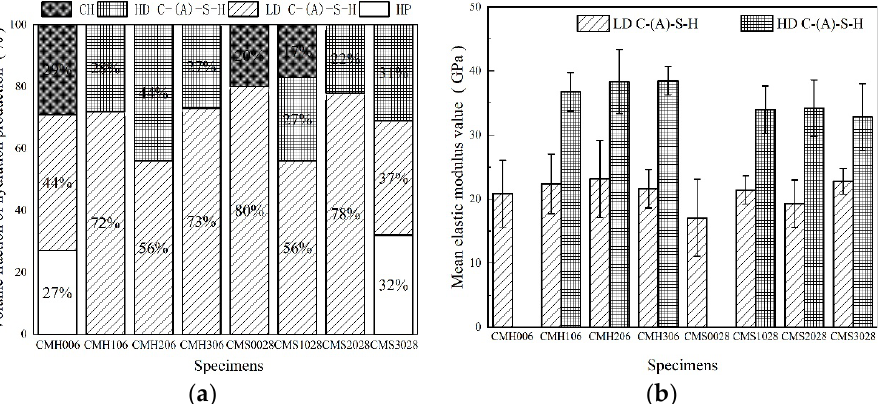
Figure 7. The volume fraction of samples ( a ) and Gaussian fitting average elastic modulus value ( b ) of C-(A)-S-H gel.